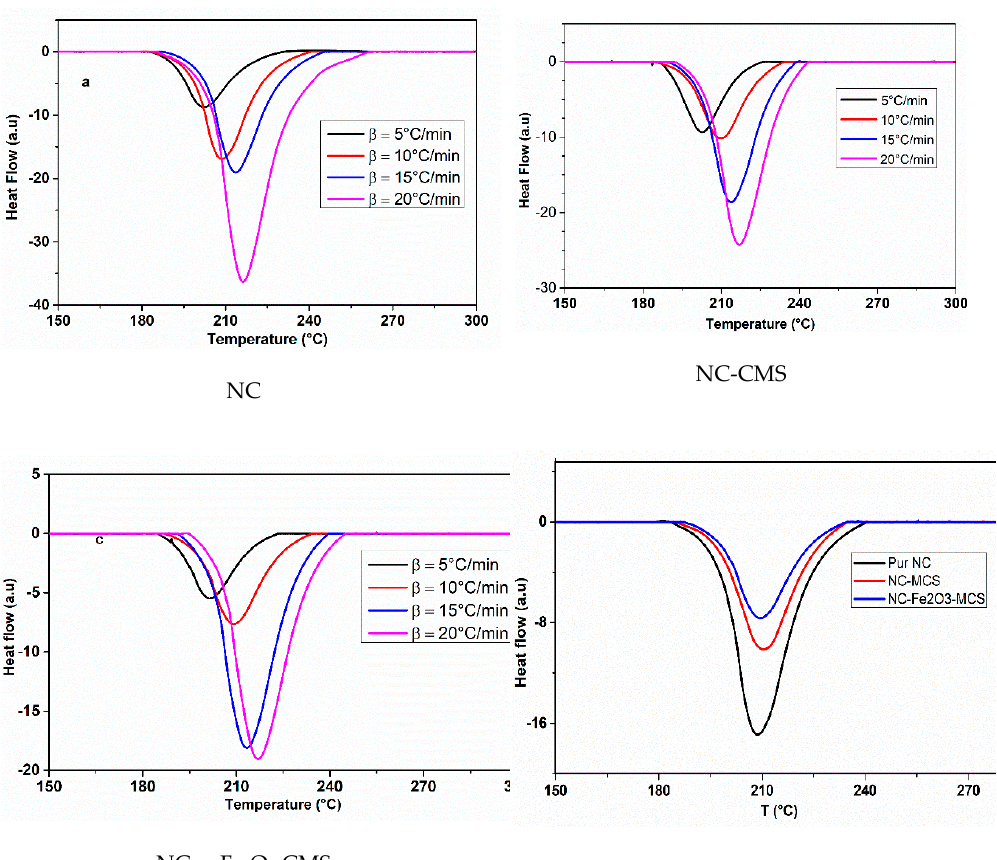
Figure 5. Differential scanning calorimetry (DSC) thermograms of pure nitrocellulose (NC), NC-CMS and NC-Fe 2 O 3 -CMS composites. Table 1. The decomposition temperatures and heat release at various heating rates for the different samples.